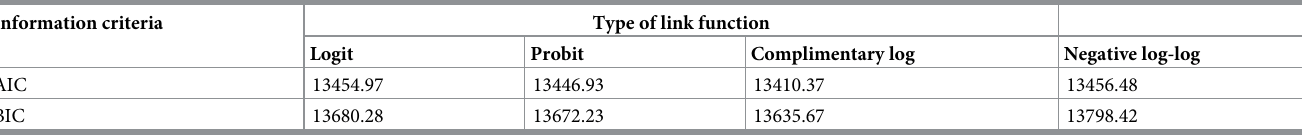
Table 4. Candidate link function for binary logistic